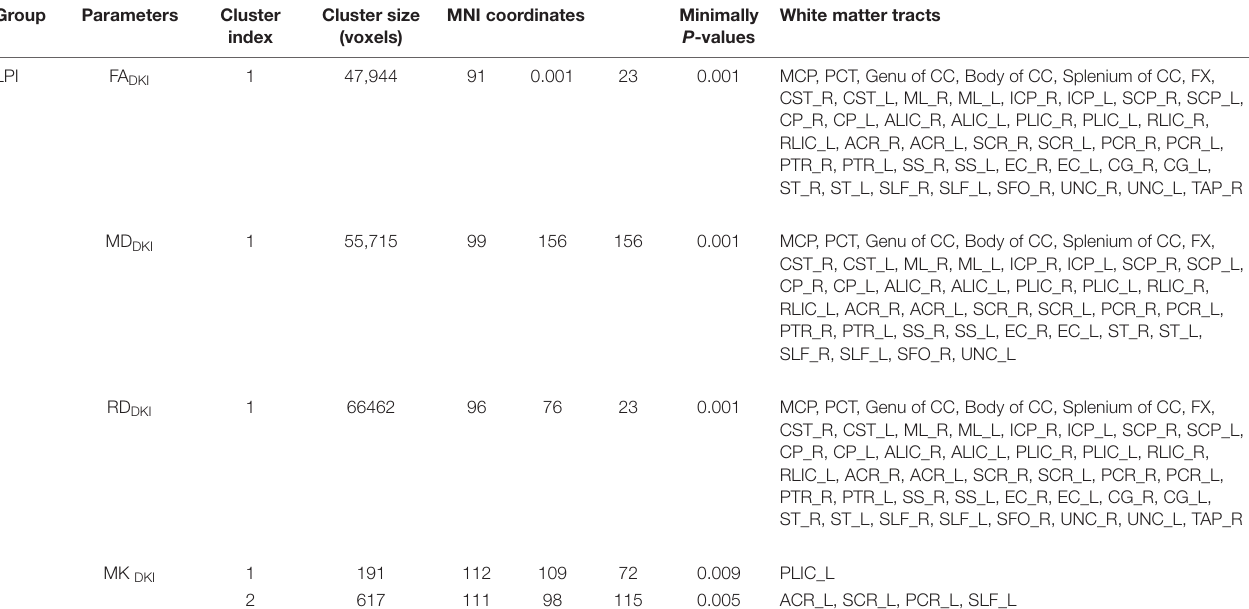
TABLE 4 | Abnormal white matter tracts derived from DKI different parameters in the LPI group. Group